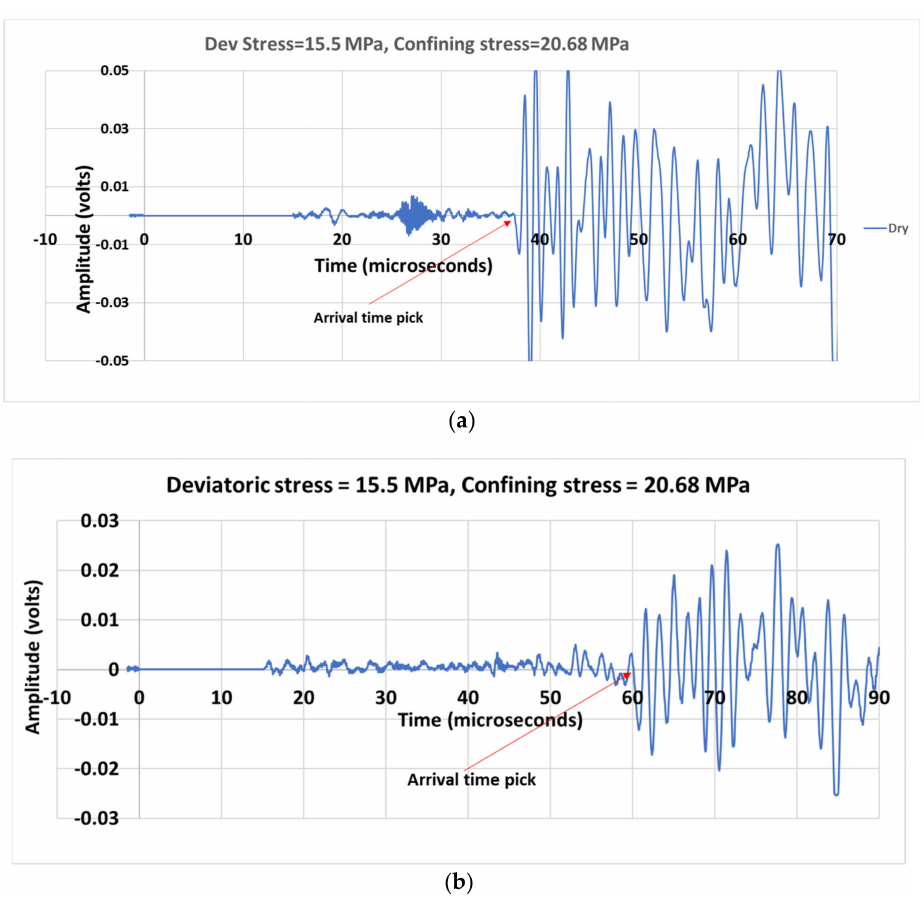
Figure 3. ( a ) Recorded P-wave at confining stress of 20.68 MPa and deviatoric stress of 15.5 MPa of the dry sample. Given the high stresses at which the measurements were made, there was no difficulty in picking the arrival times from the recorded waveforms. P-wave first arrival time pick is also shown in the figure. ( b ) Recorded S-wave at confining stress of 20.68 MPa and deviatoric stress of 15.5 MPa of the dry sample.